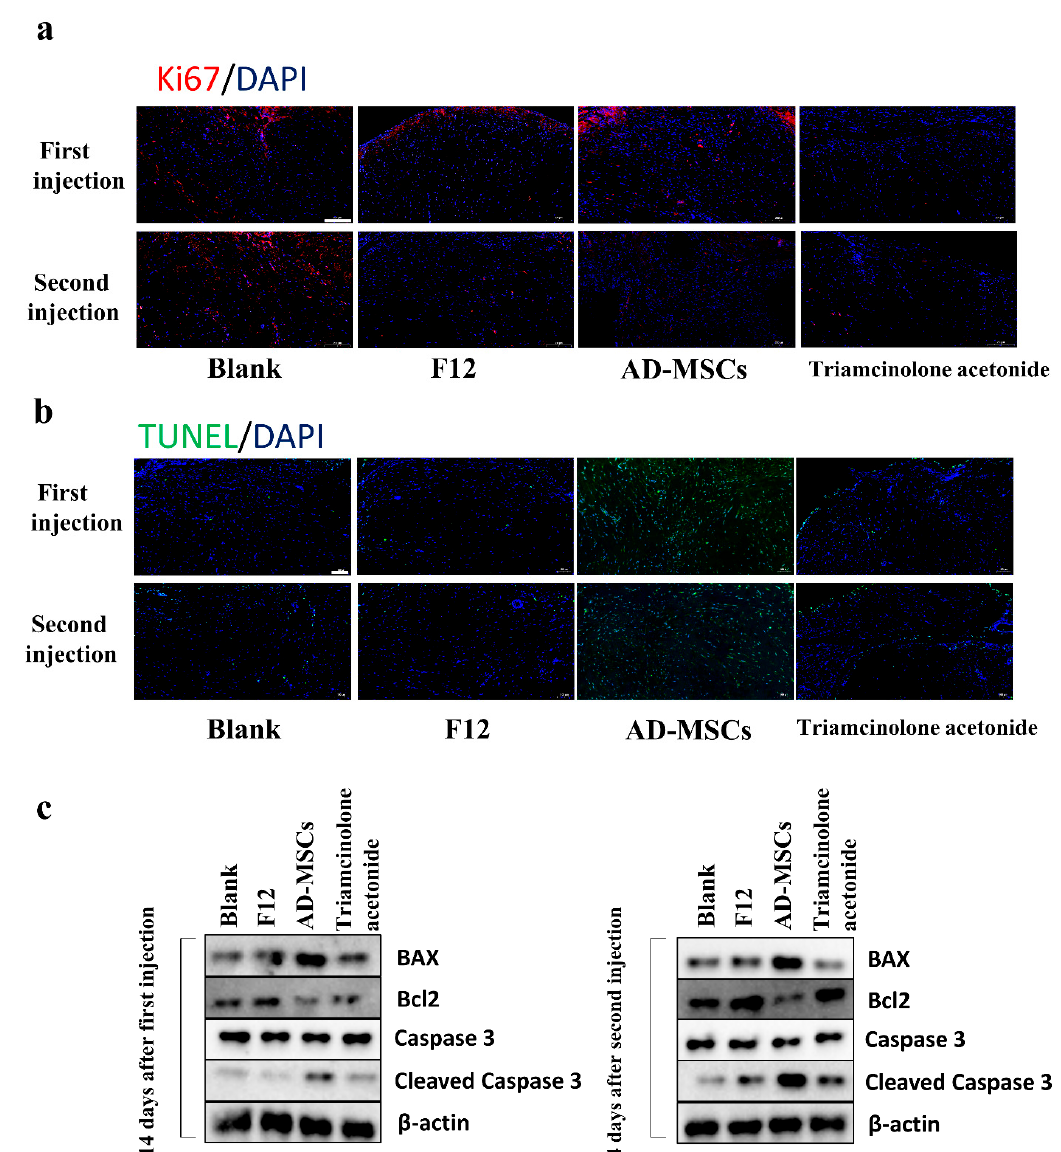
Figure 7. AD-MSCs induced apoptosis of hypertrophic scar tissue transplanted in nude mice. ( a ) Proliferation of cells was determined with immunofluorescence using antibodies against Ki67 in sections from transplanted tissues after the first and second injection of blank, F12, AD-MSCs, and triamcinolone acetonide groups. Scale bar = 200 μ m. ( b ) Estimated apoptosis in sections from transplanted tissues after the first injection and second injection of blank, F12, AD-MSCs, and triamcinolone acetonide groups using the TUNEL assay. Scale bar = 100 μ m. ( c ) Western blot analysis of Bcl-2, Bax, Caspase 3, and cleaved Caspase 3 protein levels in transplanted tissues after the first and second injection of blank, F12, AD-MSCs, and triamcinolone acetonide groups. We also detected the expression of Nrf2 and HO-1 in the transplanted hypertrophic scar tissues after treatment to identify changes in the Nrf2 and antioxidant enzymes in vivo. As expected, the changes in these substances were consistent with those seen in vitro. As shown in Figure 8a,b, the expression of Nrf2 was lower in the tissues after AD-